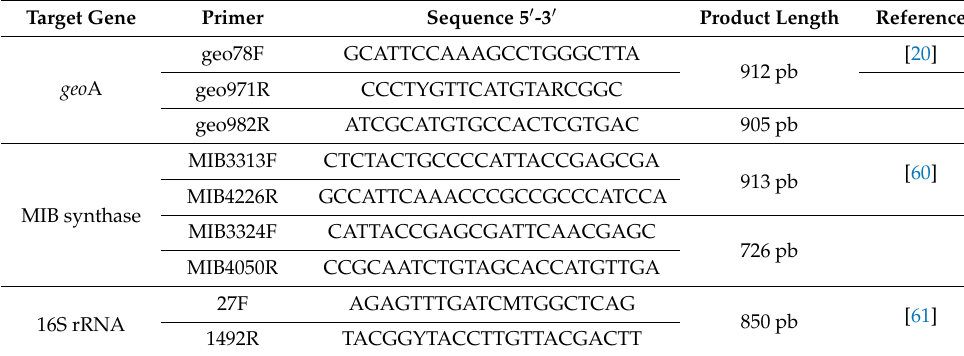
Table 2. Primer pairs were used for PCR and sequencing of geo A, MIB synthase, and 16S rRNA genes to assess concentrations of off-flavor